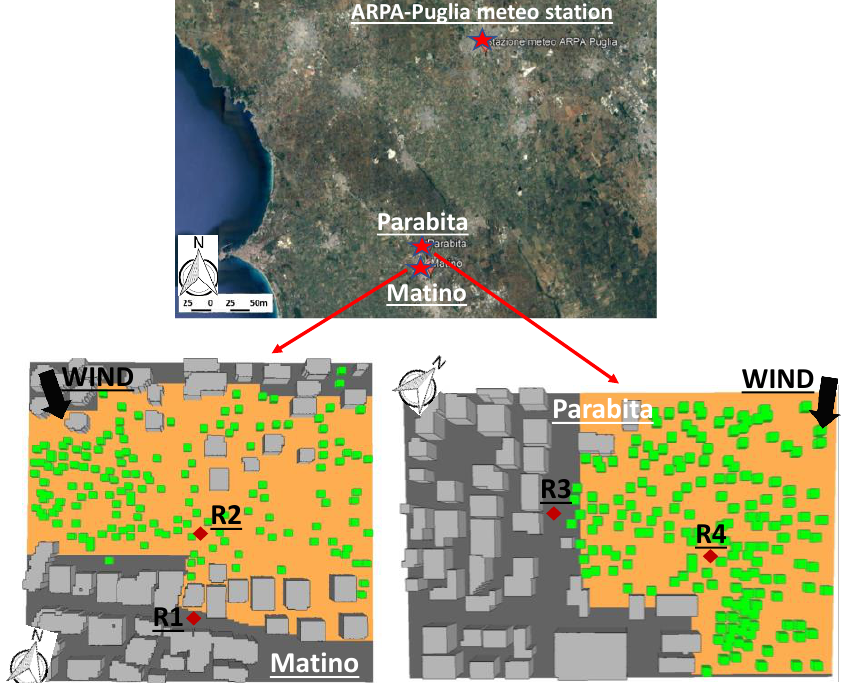
Figure 3. Geographical position of the ARPA-Puglia meteorological station with indication of the study neighborhoods (Matino and Parabita) (from Google Earth) and their reconstructions in ENVI-met (red rhombus indicate the receptors where data have been extracted for microclimate analysis).